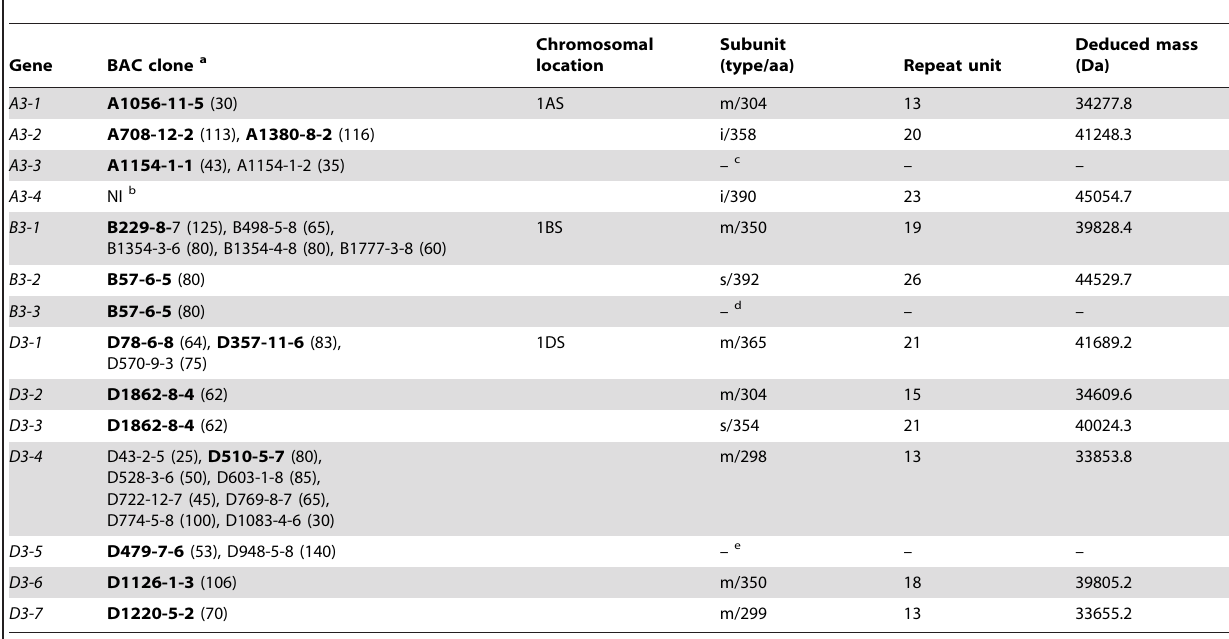
Table 1. The 14 LMW-GS genes of Xiaoyan 54 isolated by BAC sequencing and PCR amplification, and the main characteristics of subunits deduced from active LMW-GS gene